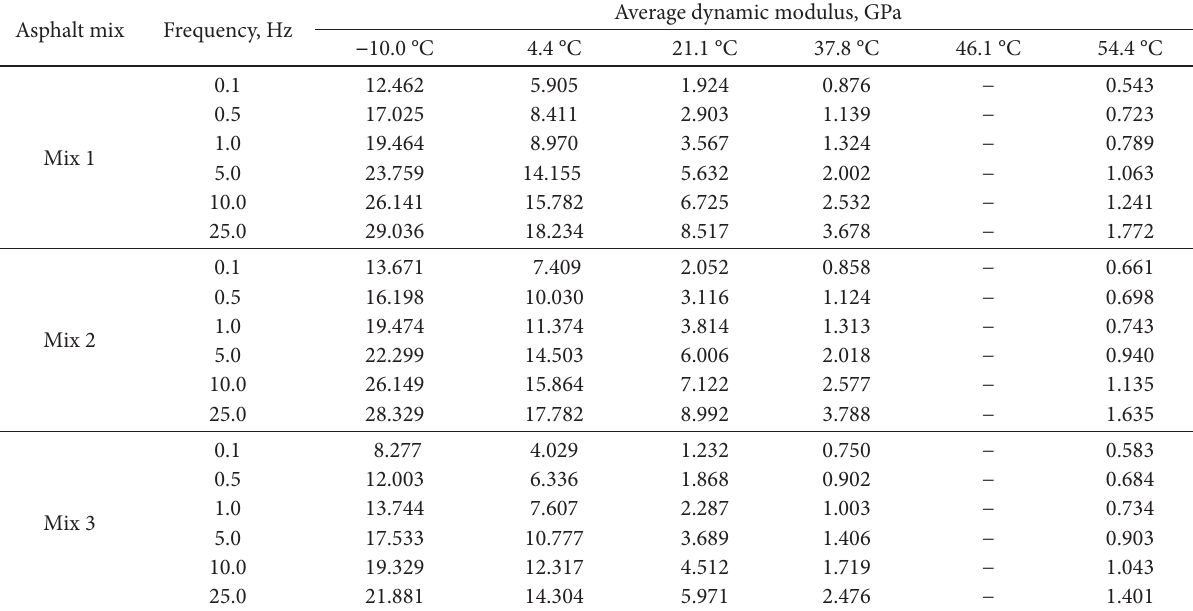
Table 5. Dynamic modulus test results for different HMA mixes Asphalt